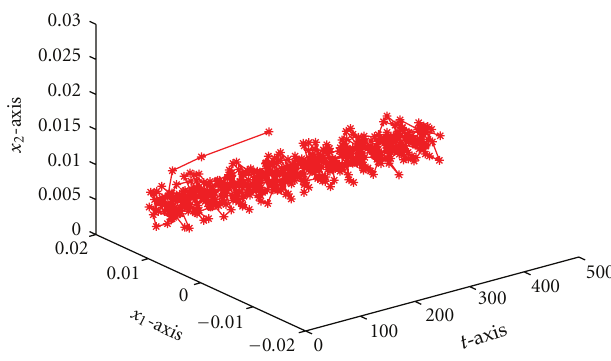
Figure 6: Phase response of state variables x 1 ,x 2 with time t in Example